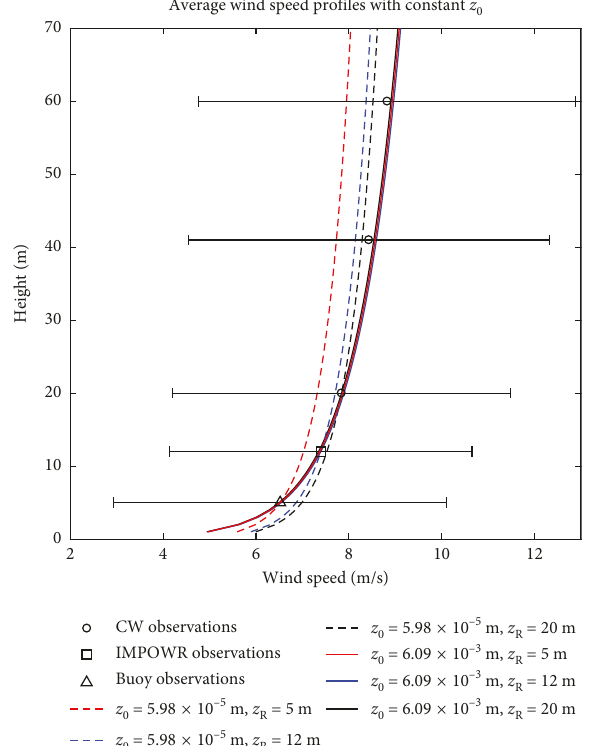
Figure 8: Average wind speed profiles based on two median values for z 0 obtained via the analytical method in the IMPOWR cam- 5 m dashed lines) and via paign (12 m reference height, 5 . 98 10 × the statistical method in the CW Historical campaign (20-m ref- − 3 m solid lines). The three reference erence height, 6 . 09 10 × heights are 5m (typical buoy height, red), 12 m (blue), and 20m −